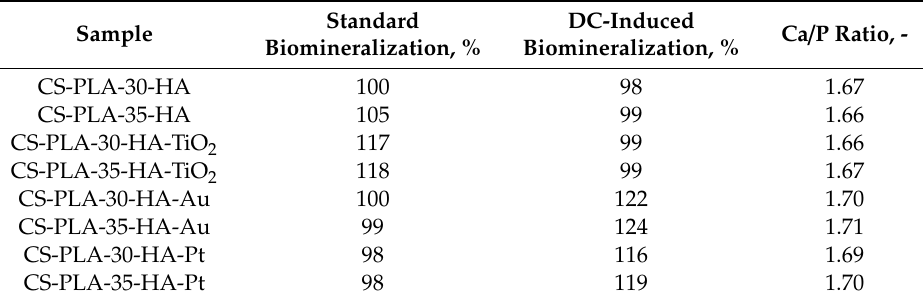
Table 2. Biomineralization e ffi ciency after seven days of incubation in SBF. Standard Sample Biomineralization, %